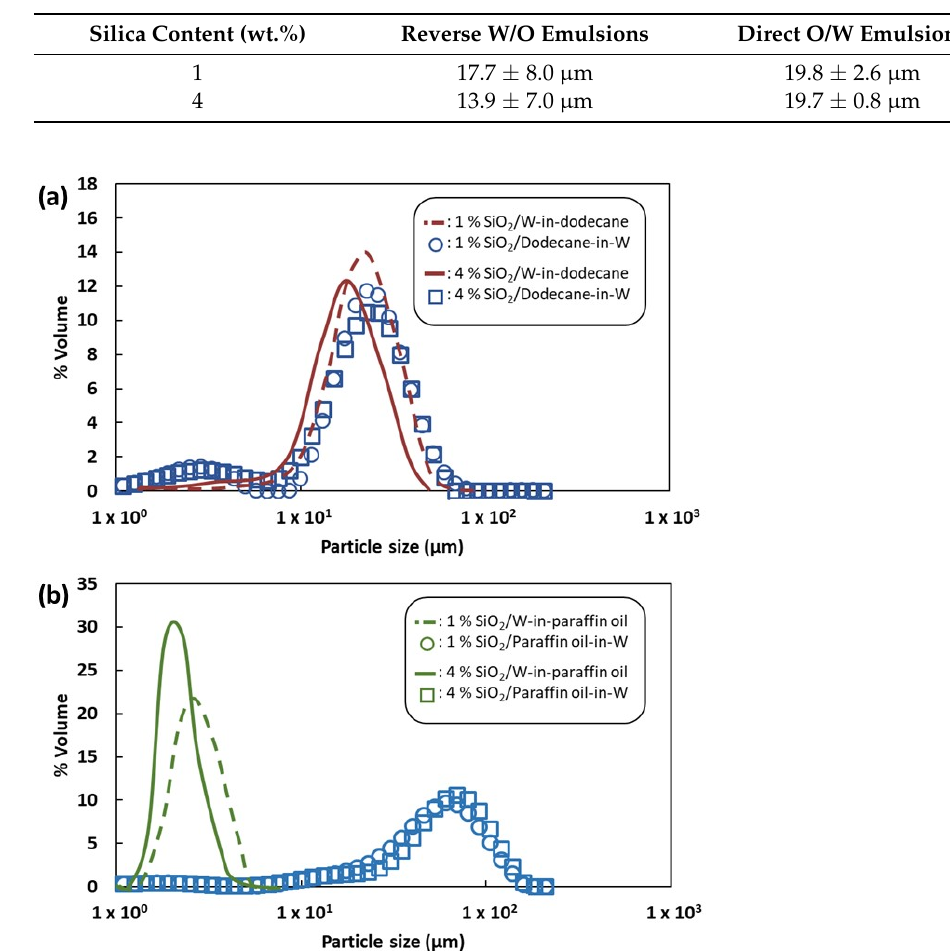
Figure 4. Droplet size distributions of ( a ) dodecane: reverse water-in-dodecane and direct dodecane- in-water emulsions, and ( b ) paraffin: reverse water-in-paraffin oil and direct paraffin oil-in-water emulsions with 1 or 4 wt.% of silica particles.